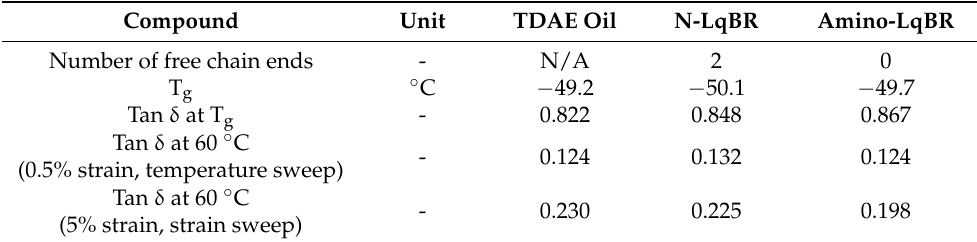
Table 9. Viscoelastic properties of